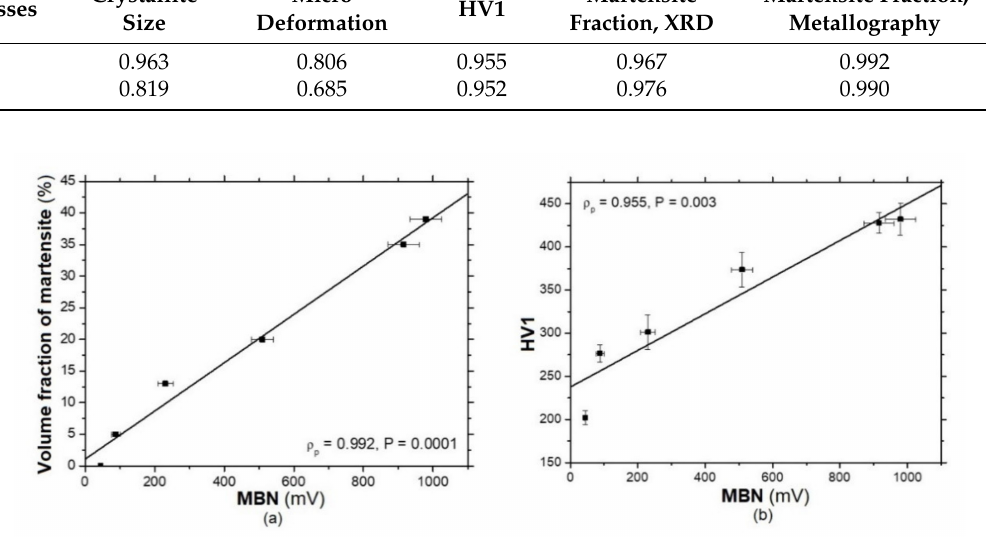
Figure 15. Correlation relationships of MBN for the direction 0 ◦ . ( a ) MBN versus volume fraction of martensite, metallography, ( b ) MBN versus